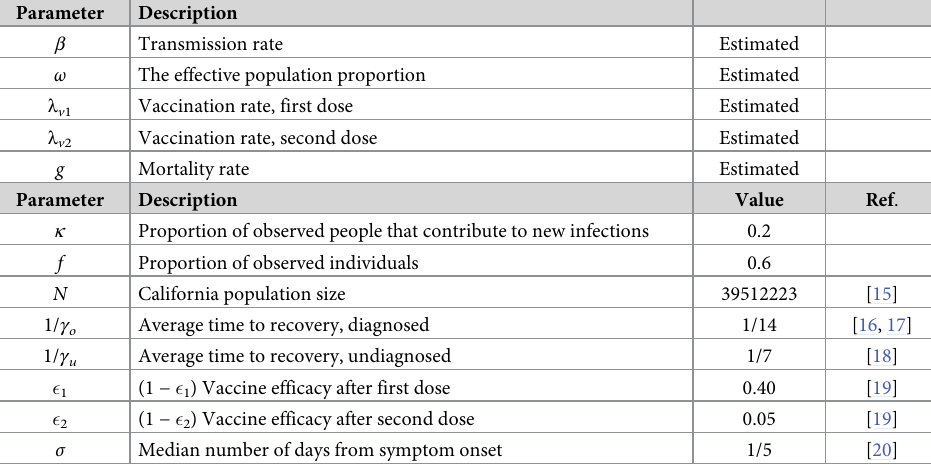
Table 1. Parameter definition and